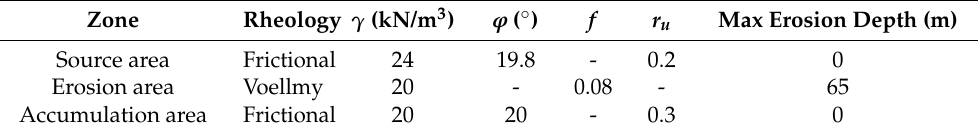
Table 2. Simulation parameters for the landslide that occurred on 9 April 2000. Zone Erosion